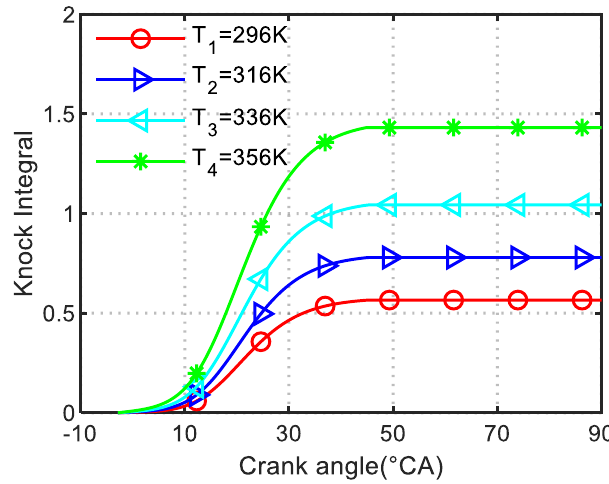
Figure 14. Knock integral under different intake temperature.